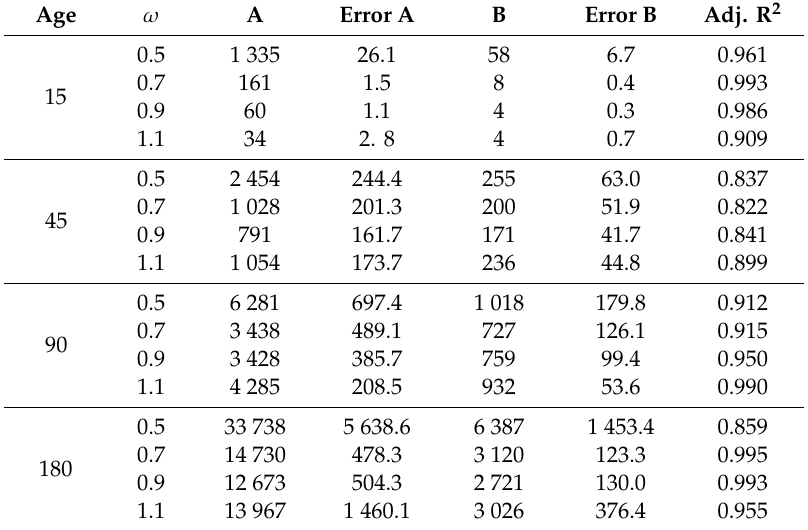
Table 2. Regression parameters A and B as determined by fitting Equation (4) to the data shown in Figure